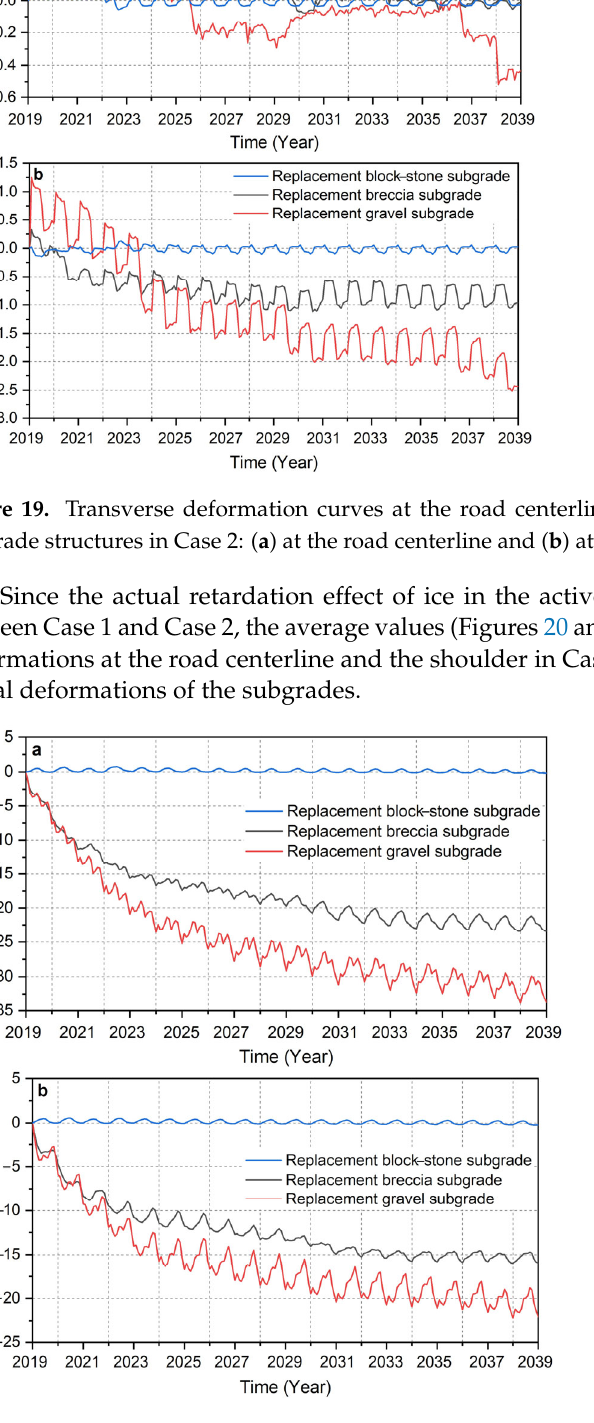
Figure 20. Actual vertical deformation curves at the centerline and the shoulder of the three subgrade structures: ( a ) at the road centerline and ( b ) at the shoulder.